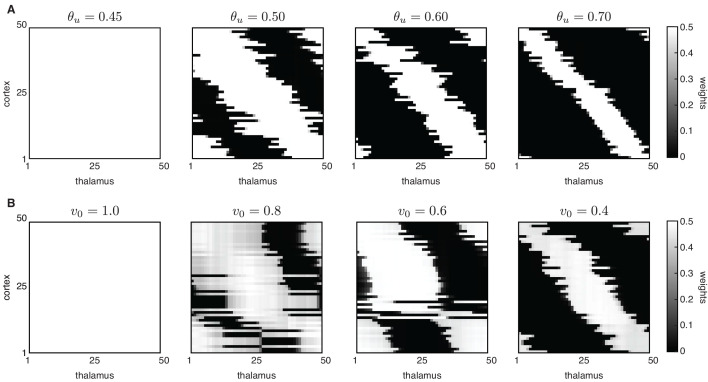
Peripheral L-events generate robust receptive field refinement in the absence of H-events. (A) Receptive fields generated by the Hebbian covariance rule with only L-events and varying input threshold θu. (B) Receptive fields generated by the BCM rule with only L-events and varying target output target rate v0.